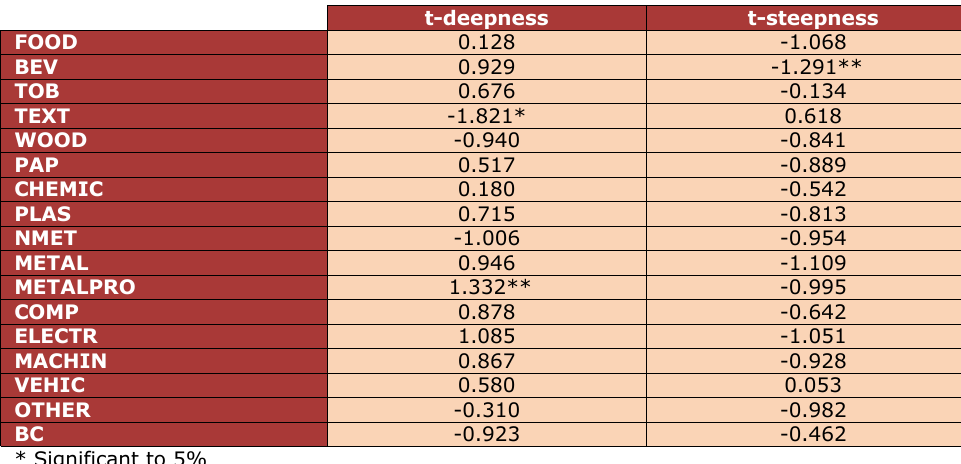
Table 3. t-ratio deepness and steepness asymmetry